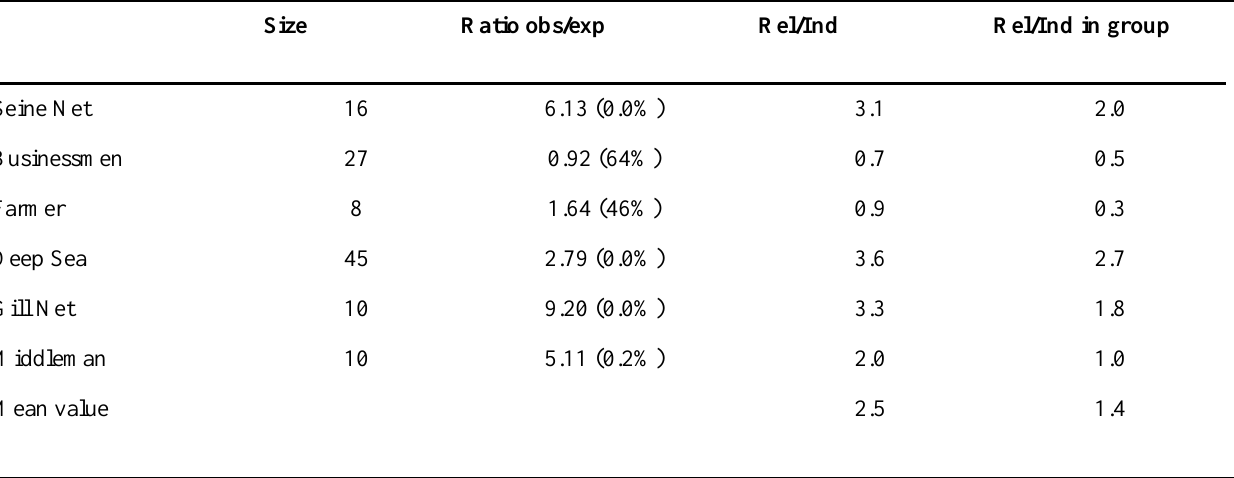
Table 2. Distribution of self-reported, within-group relations among occupational groups (Questions 4 and 5 in Table 1). Size refers to the number of individuals within respective occupation, Ratio refers to the ratio of observed vs. expected within-group relations based on an assumed random distribution of all relations, Rel/Ind refers to the total number of reported relations to individuals irrespective of their occupation, divided by the number of members within the group, and Rel/Ind in group refers to the number of reported within-group relations divided by the number of group members. The numbers in parentheses represent the probabilities (%) of acquiring a higher ratio, assuming independence between the occupational categories and probability for relational ties. For example, for the within-group ratio of businessmen (0.92), the probability of acquiring a higher ratio would be